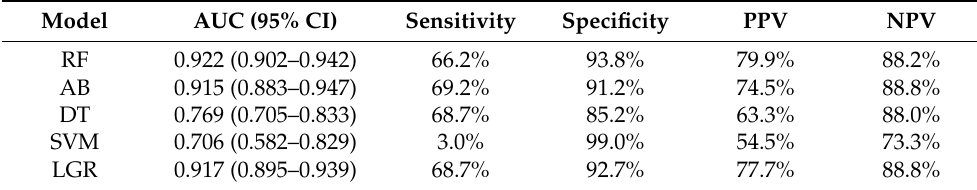
Table 4. AUC, sensitivity, specificity, PPV, and NPV of each machine learning model.